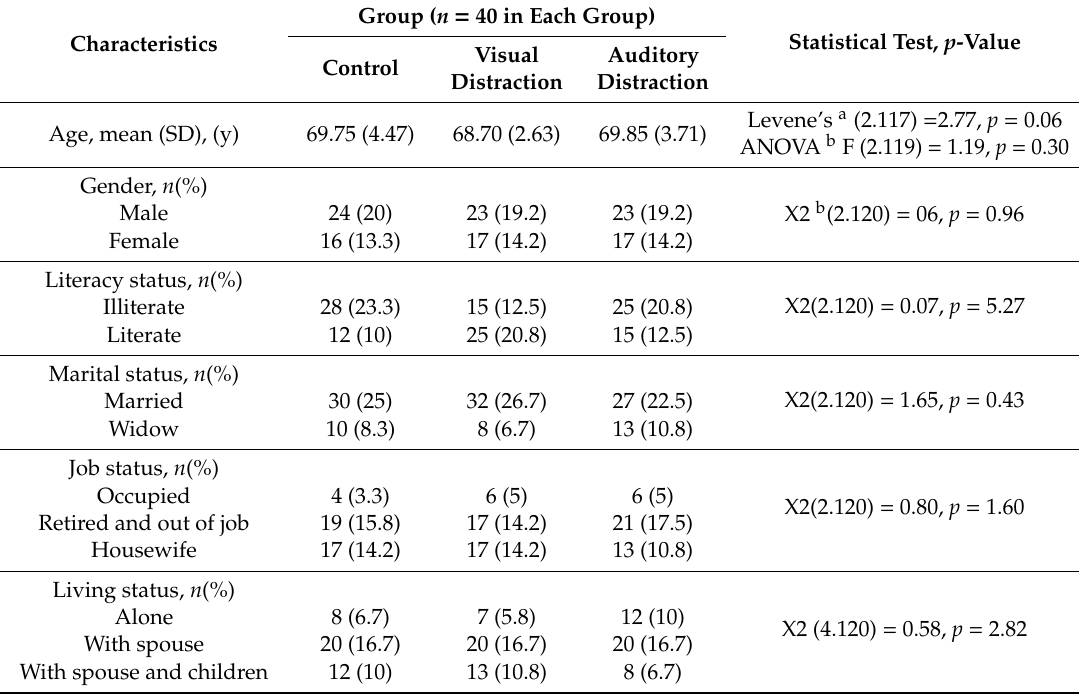
Statistical Test, p -Value